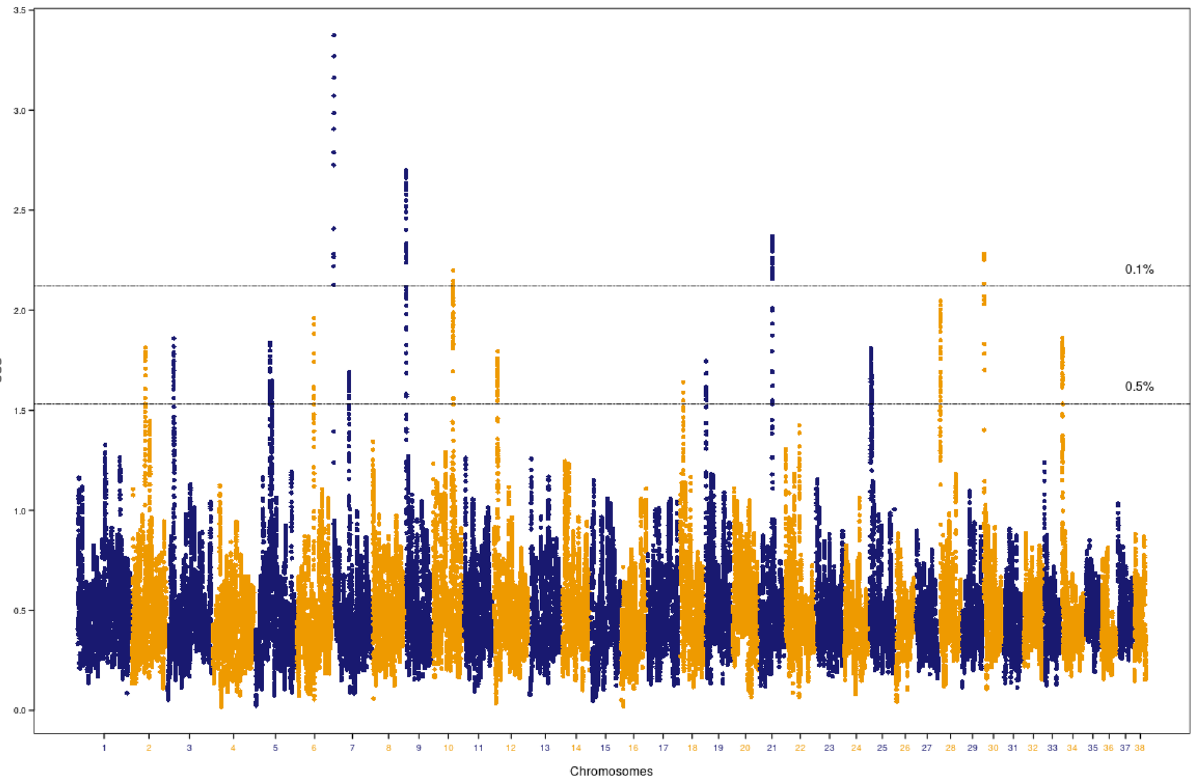
Figure 1. Composite selection signals associated with adaptation to high altitude. CSS statistics were determined with Qinghai-Tibetan Plateau dogs as the target group. The canine chromosomal positions of SNP markers are plotted on the x-axis. The observed values for selection scan statistics based on the combination of F st , ∆DAF and XP-EHH are highlighted in blue and orange. Each point represents the smooth CSS value in a 1 Mb overlapping sliding window across the autosomes. The two-dashed horizontal lines indicate threshold values for the top 0.1% (top) or 0.5% (bottom) of CSS values.